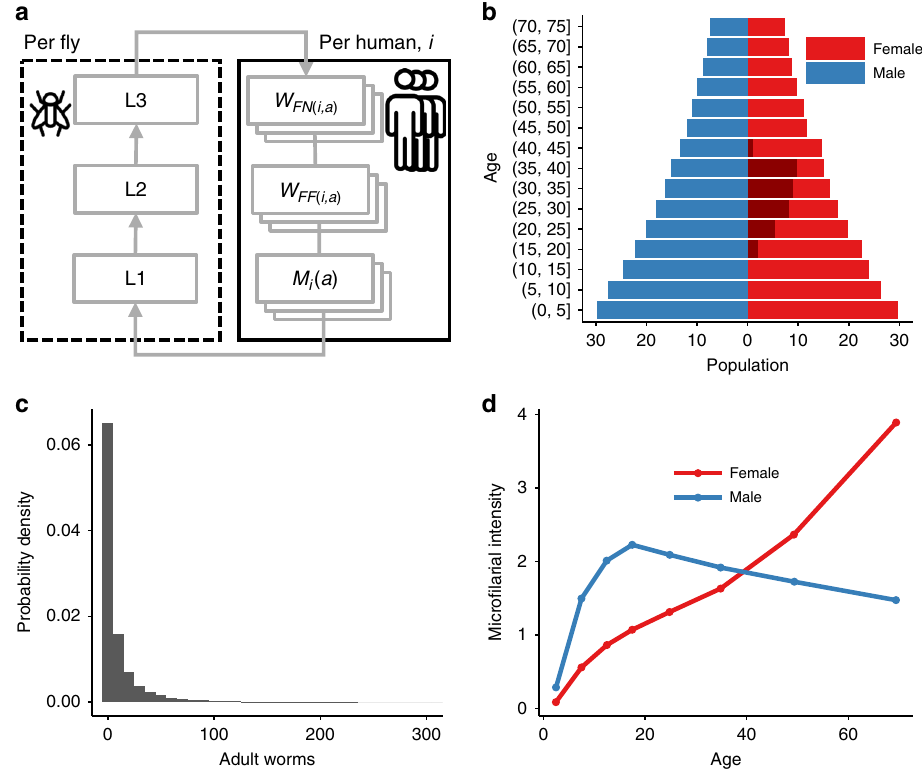
Fig. 2 Schematic description of EPIONCHO-IBM. EPIONCHO-IBM is an individual-based analogue of the population-based (deterministic) EPIONCHO transmission model 47,49 tracking the number and age ( a ) of adult non-fertile ( W FN ( i , a ) ) and fertile ( W FF ( i , a ) ) female Onchocerca volvulus worms, micro fi lariae ( M i ( a )) and male worms (not represented schematically) within individual (human) hosts ( i ) and the mean number of L1, L2 and L3 larvae in black fl y vectors ( a ). Host births, deaths and age are based on the typical demography of rural low-income communities in Africa ( b ) and we additionally model explicitly the pregnancy and breastfeeding status of women between the ages of 16 and 40 years (shaded dark red ( b )). Individuals are differentially exposed to black fl y bites, driving the typically overdispersed (aggregated) distribution of parasites among hosts, such that most people are either uninfected or lightly infected and few have many adult parasites (and micro fi lariae) ( c ). Exposure to black fl y bites depends on age and varies between boys and girls/ men and women, and is implicitly related to the amount of time spent in areas of high black fl y (vector) density. In this parameterisation, based on data from an onchocerciasis focus in northern Cameroon, girls are relatively less exposed than boys and women are relatively more exposed than men ( d ) 78 . The parasite population is regulated by density-dependent processes operating within the black fl y vector, and on the establishment of incoming worms and the mating of (female) adult worms with the human host. Female worms in a host are assumed to produce micro fi lariae if at least one male worm is present (i.e., polygamous mating). Table 1 Parameters varied in the clinical trial